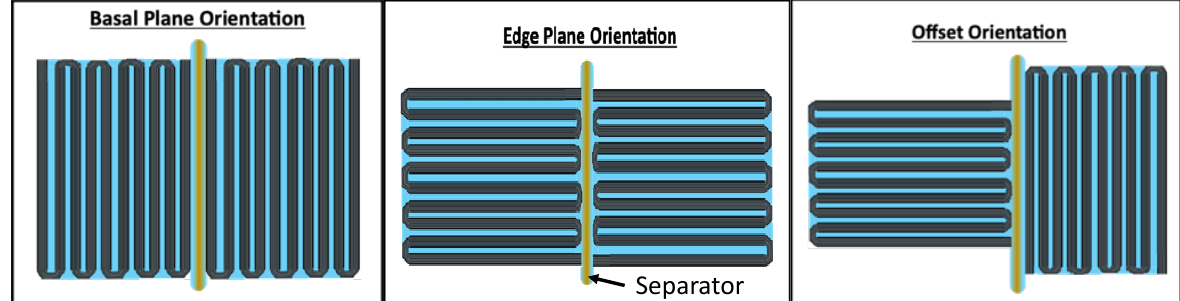
Figure 3. Edge View of the Grafoil Sheet Orientation. Capacitors were constructed using accordion folded Grafoil with three ‘specific orientations’ relative to the separator, as illustrated.